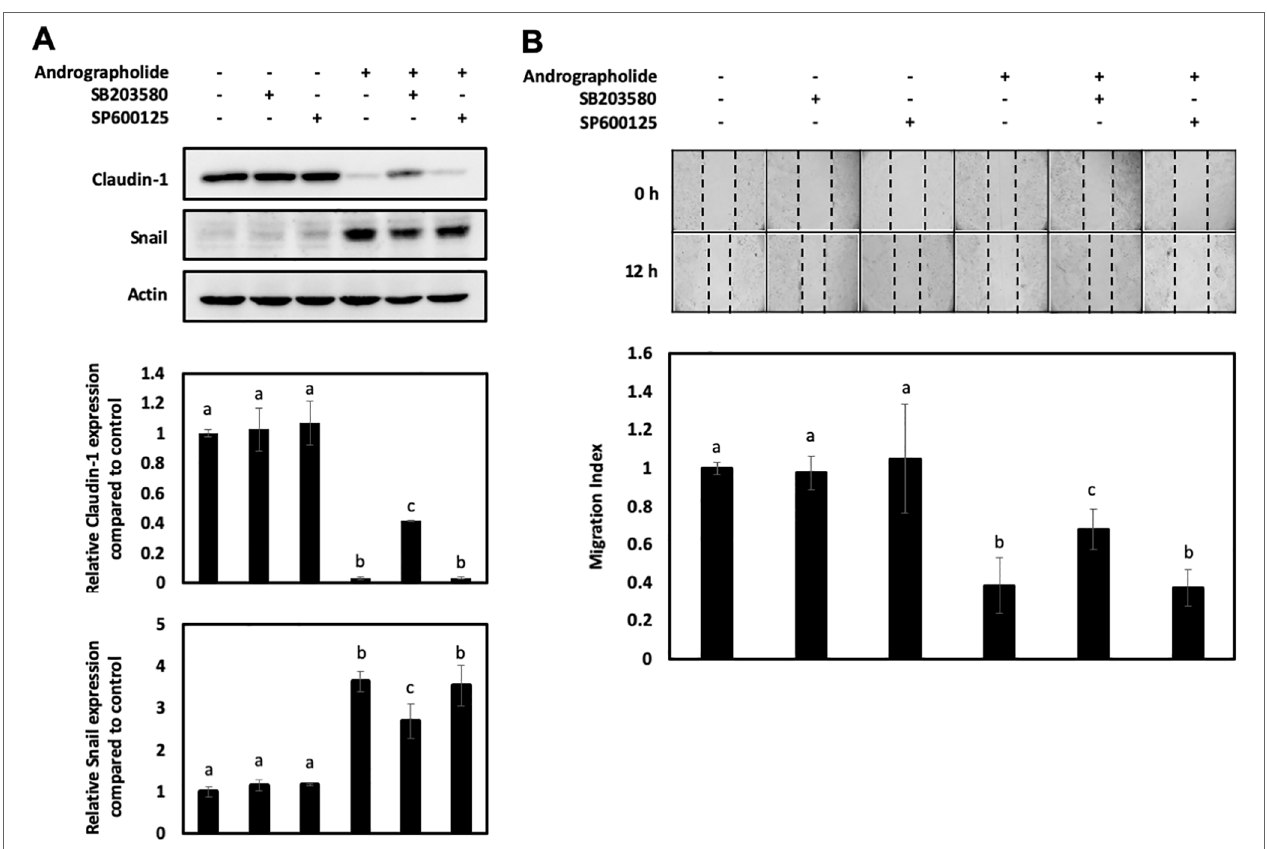
FIGURE 6 | Effect of p-38 MAPK inhibitor (SB 203580) and JNK inhibitor (SP500125) on KKU-M213 treated with andrographolide. (A) KKU-M213 was treated with 50 µM of andrographolide or DMSO control for 24 h prior to the treatment with the inhibitors. Proteins from cell lysate were analyzed for the expression of claudin-1 and Snail, and actin was used as an internal control. (B) KKU-M213 cells with treatment of andrographolide and the inhibitors were scratched and photographed at 0 and 12 h to measure the wound length for migration index analysis. The results of bar graph are represented by the average of relative intensity compared with that of the control. Data are presented as mean ± SE, which were derived from three independent experiments. Lowercase letters similar between treatments represent no statistically significant